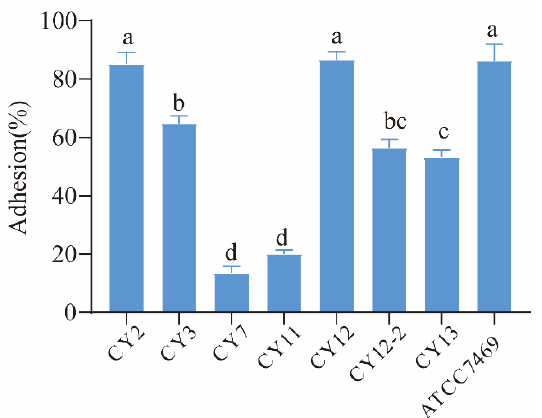
Figure 2. Adhesion rate of selected strains. a – d means different superscript letters are different per p < 0.05.